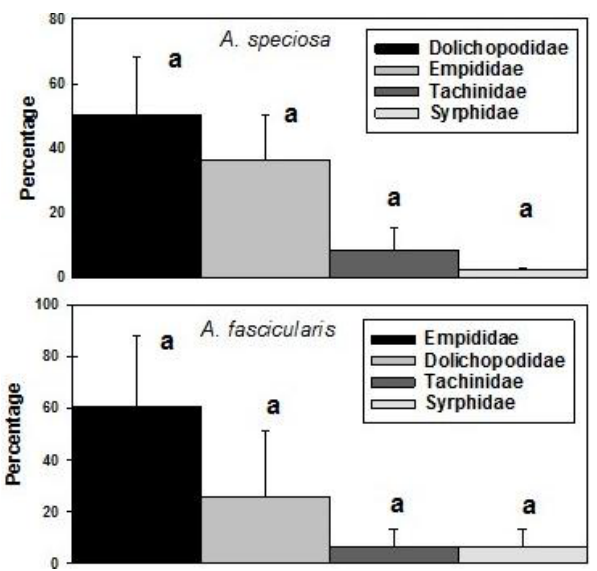
Figure 3. Mean (±SE) percentage per season of families comprising the predatory and parasitic fly category trapped on A. speciosa and A. fascicularis during 2010–2013 ( speciosa ) and 2012–2014 ( fascicularis ). Bars denoted by the same letter are not significantly different ( p = 0.05).